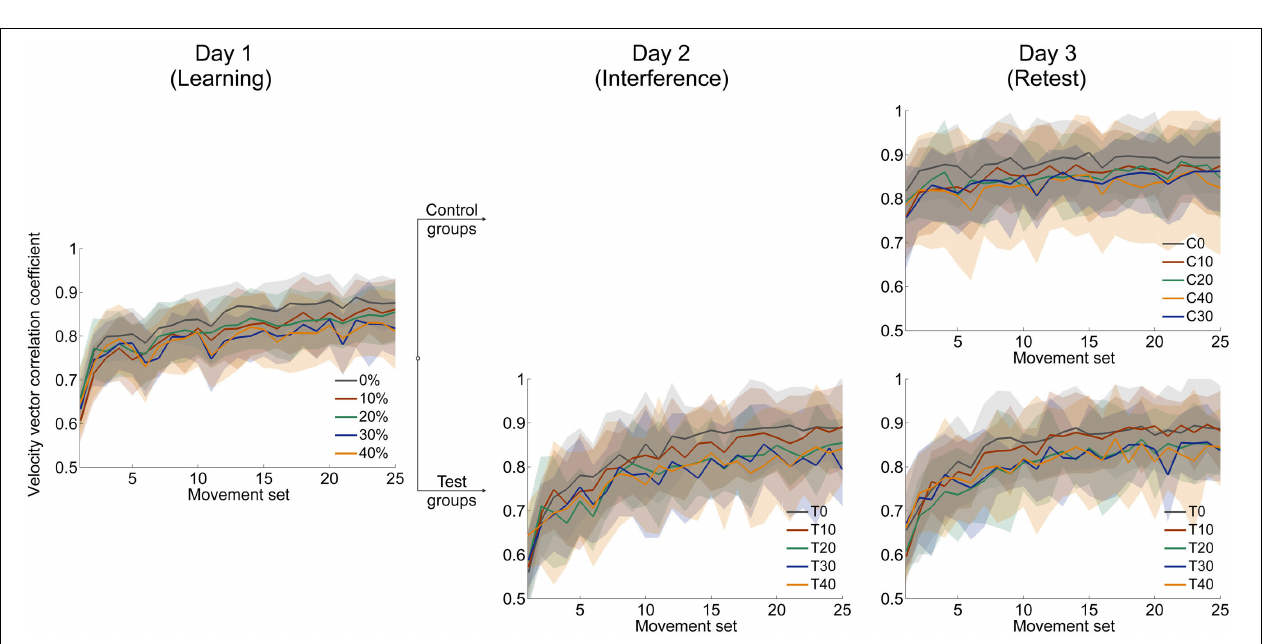
FIGURE 3 | Mean time courses of velocity vector correlation coefficient for all three days. After learning force field A on day 1 (left) , subjects of each catch trial ratio group were divided into control and test groups. Test groups adapted to an interfering force field B = − A on day 2 (mid) . On day 3, all